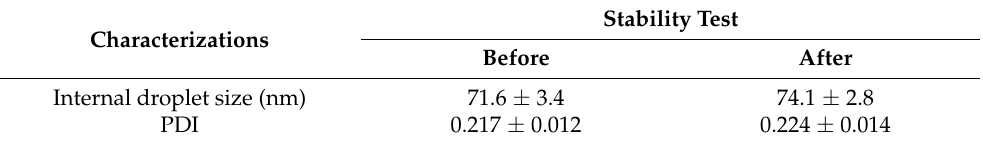
Table 3. Internal droplet size and PDI of AGO microemulsion before and after the stability test. Characterizations